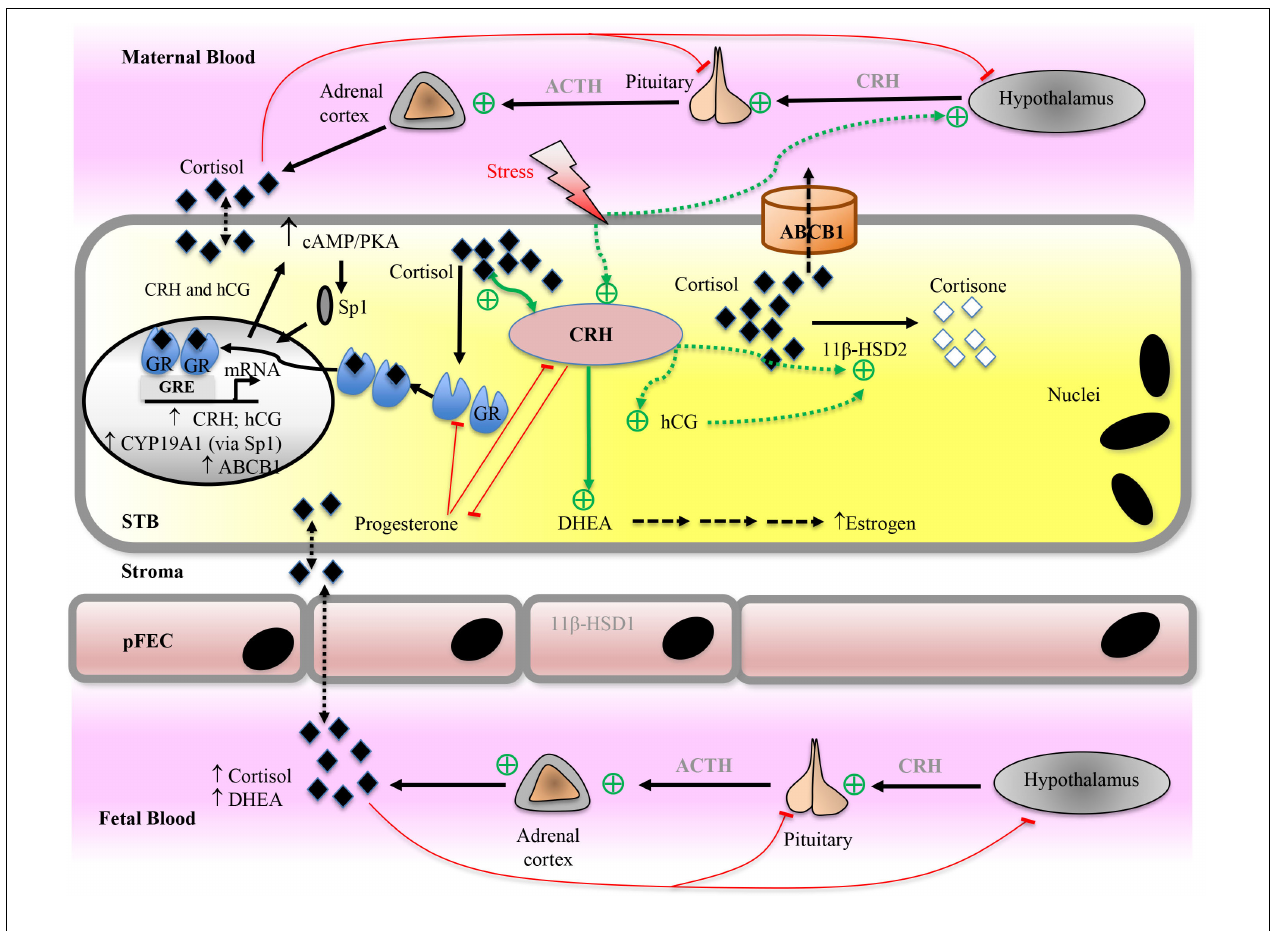
FIGURE 8 | Proposed model for placental glucocorticoid (cortisol) function and metabolism. For detailed description, see text. Cortisol can diffuse across cell membranes and regulate target protein expression directly via glucocorticoid receptor (GR) or indirectly via other transcription factors (e.g., Sp1). Placental corticotropin-releasing hormone (CRH) is the major mediator of adaptive response to stressors during pregnancy. Cortisol stimulates placental CRH expression, which regulates placental hormone levels (e.g., hCG, estrogen, progesterone, and 11 β -HSD2). Red arrows indicate inhibiting/negative feedback pathways, while green arrows indicate stimulating pathways. ABC transporters, ATP-binding cassette transporters; ACTH, adrenocorticotropic hormone; CRH, corticotropin-releasing hormone; DHEA, dehydroepiandrosterone; GRE, glucocorticoid response element; HSD, hydroxysteroid dehydrogenase; hCG, human chorionic gonadotropin; pFEC, placental-fetal endothelial cell; PKA, protein kinase A; Sp1, specificity protein 1 transcription factor; STB,